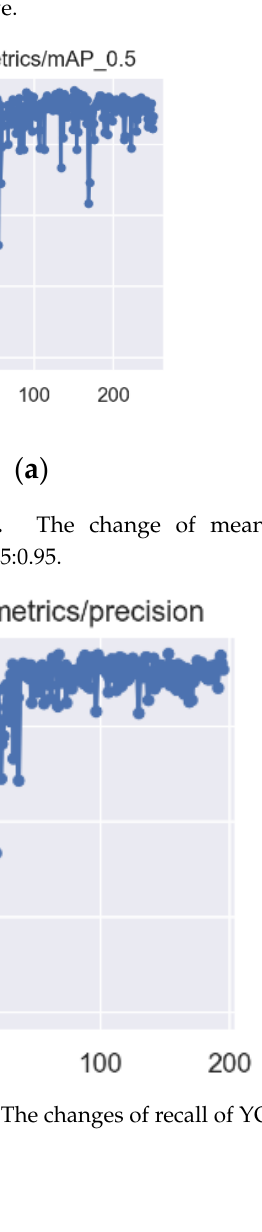
( b ) Figure A5. The precision/recall curve and F 1 Score /confidence curve of YOLOV5s: ( a ) PR_curve; ( b ) F1_curve. ( a ) ( b ) Figure A6. The change of mean average precision (mAP) of YOLOV5s: ( a ) mAP_0.5; ( b ) mAP_0.5:0.95.